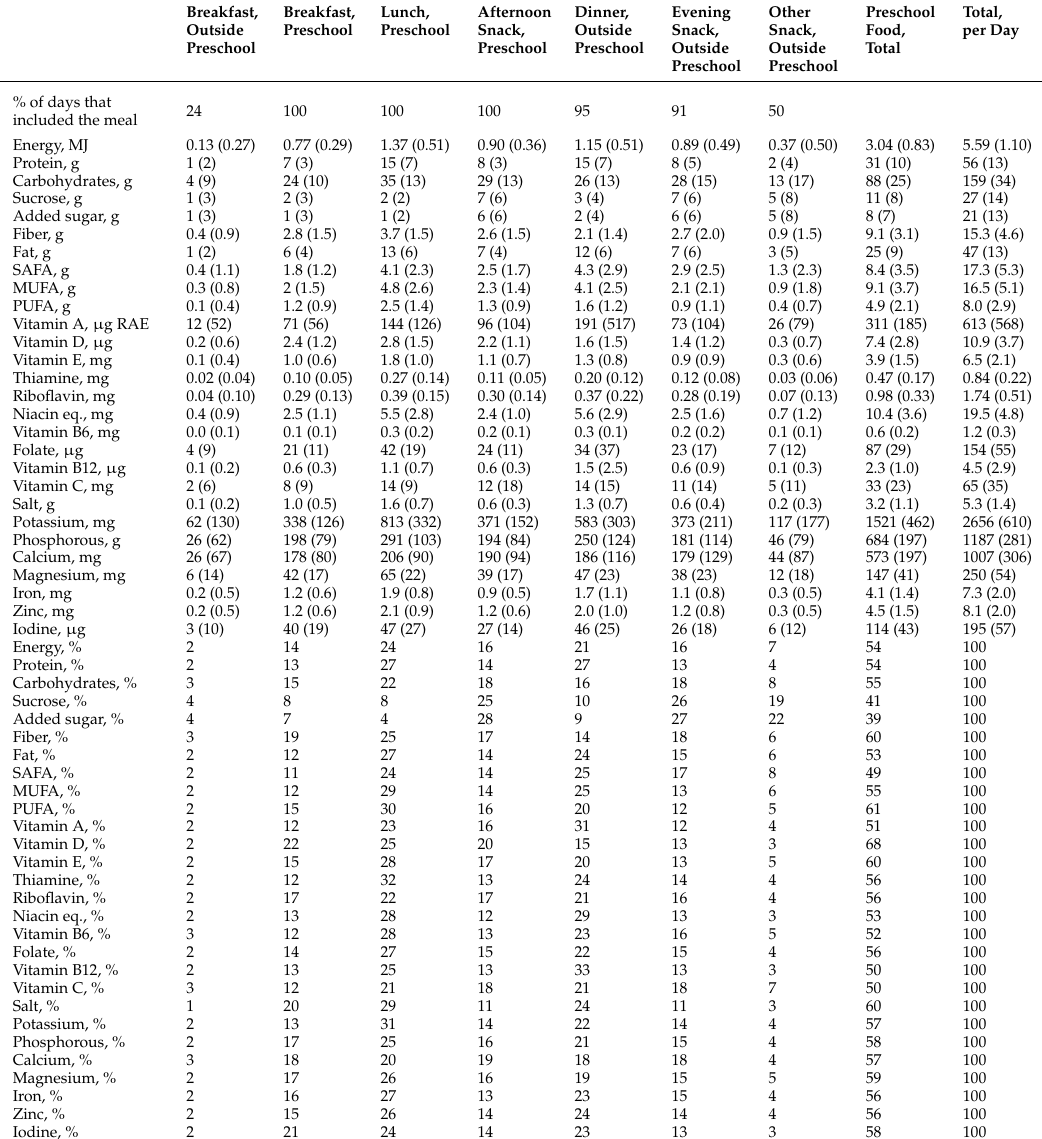
Table 4. Mean (SD) intake and population proportion [24] of energy and nutrients on weekdays among 3 to 4-year-old children who eat three meals at preschool ( n = 324). Each child had data for 1 to 4 days; the total number of days was